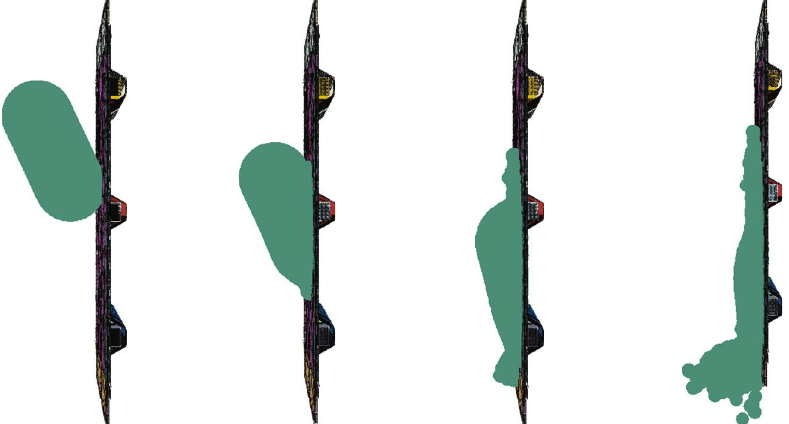
Figure 17: Morphology of the bird body at di ff erent moments of 25 ° .